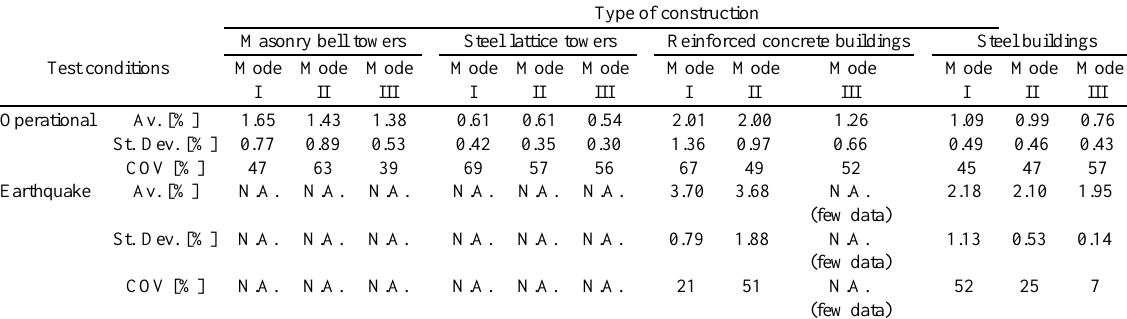
Table 1 Modal damping ratios: analysis results of data collected from the